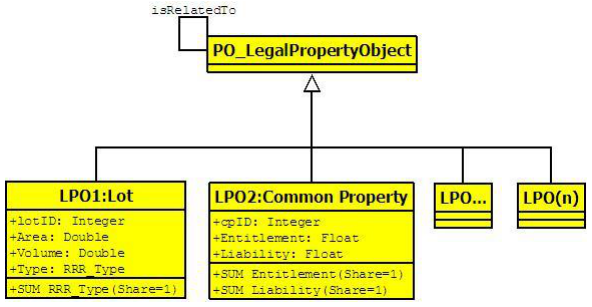
Figure 7. Attributes of PO_LegalPropertyObject